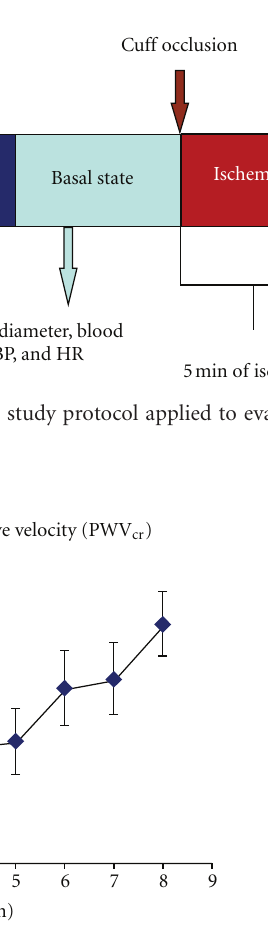
Figure 3: MV and SEM of PWV cr temporal pattern at rest (baseline) and 8 minutes after cu ff deflation. ∗ indicates significance comparing baseline to one minute after release of the cu ff . Table 2: Time delays of first and second peak of radial pulse pressure.